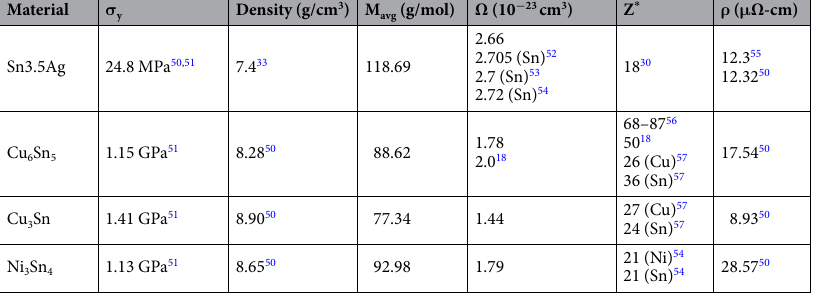
Table 1. The parameters for the calculation of the critical product. M avg : Average atomic weight; Ω = Density/M avg